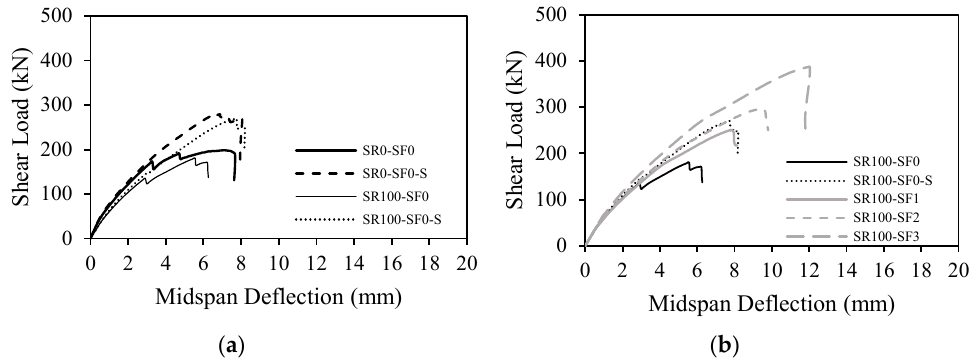
Figure 7. Numerical shear load–deflection response of group S: ( a ) beam models without steel fibers; ( b ) beam models with RCAs/steel fibers.